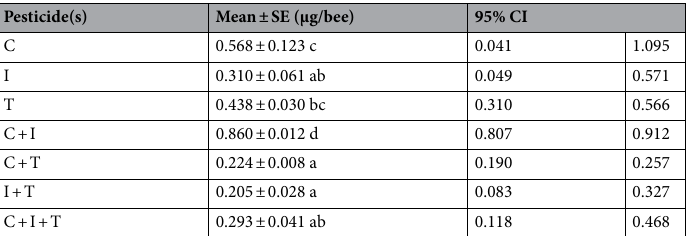
Table 1. Acute oral toxicity of pesticides (LD 50 value) to bumblebees. Different lowercase letters in the same subcolumn indicate a significant difference among the bumblebees to different pesticide(s) (one-way ANOVA followed by Duncan’s tests). CI = combination index; C = chlorpyrifos; I = imidacloprid; T =